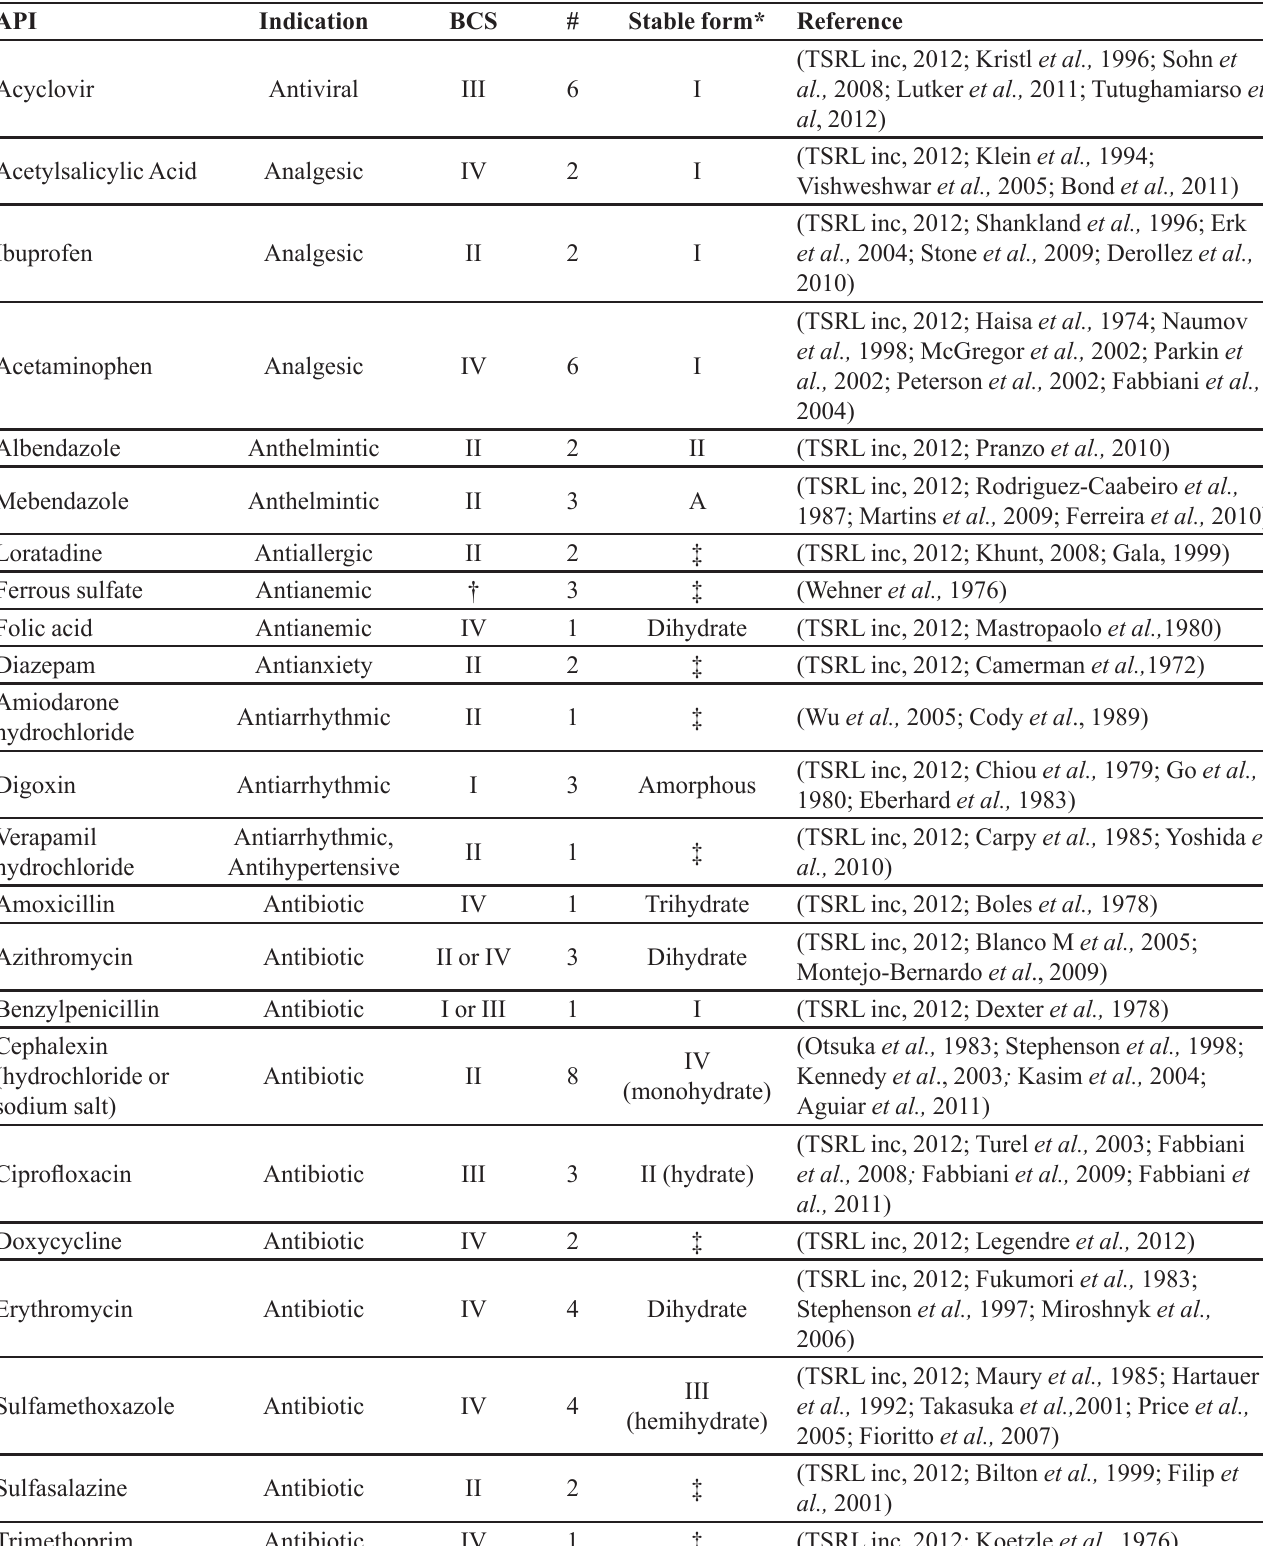
TABLE I - Solid-state forms of Farmácia Popular drugs